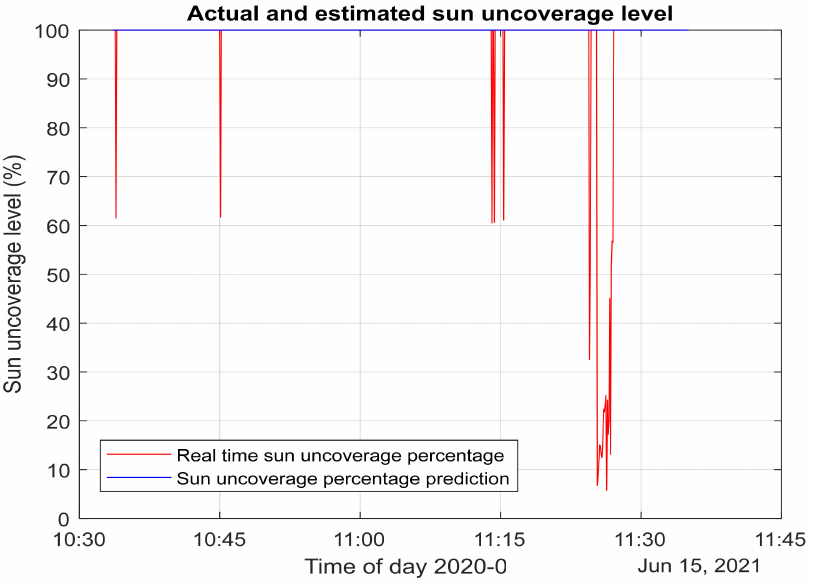
Figure 16. Comparison of real-time sun un-coverage and predicted level of sun un-coverage on 14 July 2020 from 10:30 until